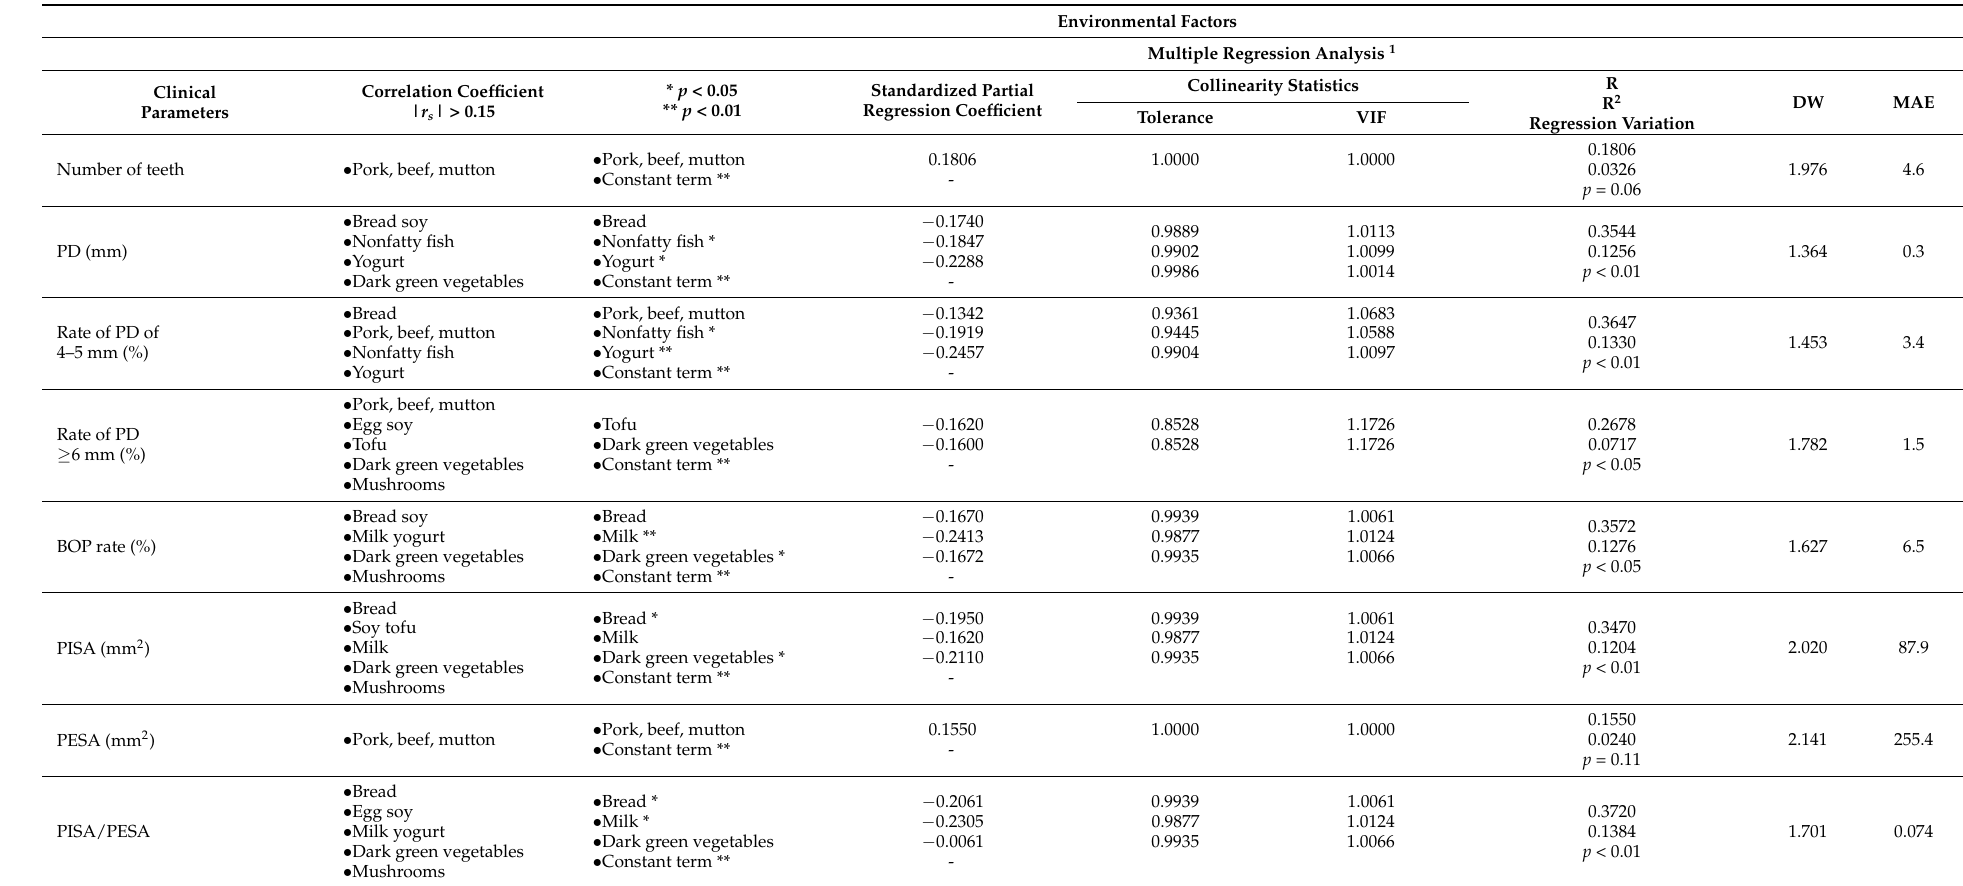
Table 2. Multiple linear regression analysis to predict clinical parameters based on nutritional